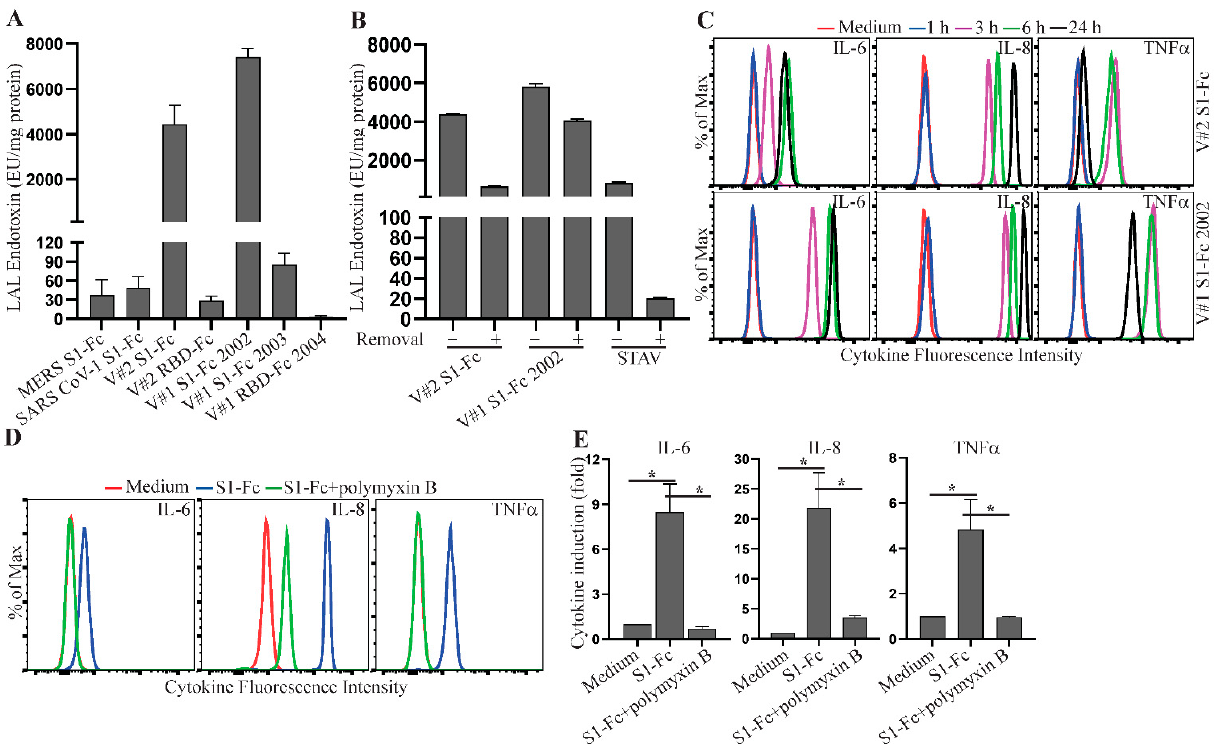
Figure 5. LPS co-purifying with spike protein reagents induces proinflammatory cytokine production. ( A ) MERS S1-Fc, SARS CoV-1 S1-Fc, S1-Fc from Vendor #2 (V#2 S1-Fc), S1-Fc from Vendor #1 (lot 24056-2002-2 (V#1 S1-Fc 2002) and lot 24529-2003 (V#1 S1-Fc 2003)), RBD-Fc from Vendor #2 (V#2 RBD-Fc) and RBD-Fc from Vendor #1 (lot 25130-2004, V#1 RBD-Fc 2004), and ( B ) V#2 S1-Fc, V#1 S1-Fc 2002 and streptavidin (STAV) before and after treatment of endotoxin removal were assessed for the levels of endotoxin using the LAL Chromogenic Endotoxin Quantitation Kit. The concentrations of endotoxin are presented as EU/mg protein. Data shown are mean ± SE of the results from three independent experiments. ( C ) Time course of S1-Fc-induced cytokine responses. Rested PBMC were cultured with or without 2.0 µg/mL of S1-Fc (V#2 S1-Fc and V#1 S1-Fc 2002) for 1, 3, 6 or 24 h. The levels of IL-6, IL-8 and TNF α in the supernatants of cultured PBMC were assessed using the CBA human inflammatory cytokine kit and flow cytometric analysis. ( D , E ) Blockade of S1-Fc-induced cytokine response by an LPS inhibitor, polymyxin B. Rested PBMC were cultured with or without 2.0 µg/mL of S1-Fc (V#2 S1-Fc) in the presence or absence of polymyxin B for 3 h. The levels of IL-6, IL-8 and TNF α in the supernatants of cultured PBMC were measured using the CBA human inflammatory cytokine kit and flow cytometric analysis. Data shown in ( D ) are representative of the flow cytometric results from three healthy donors and data shown in ( E ) are mean cytokine induction induces (fold) ± SE, which were calculated using cytokine concentrations and the formula: cytokine concentration of treated PBMC/cytokine concentration of untreated PBMC. Statistical analyses were performed using a two-tailed, Student’s t -test. * depicts p < 0.05.